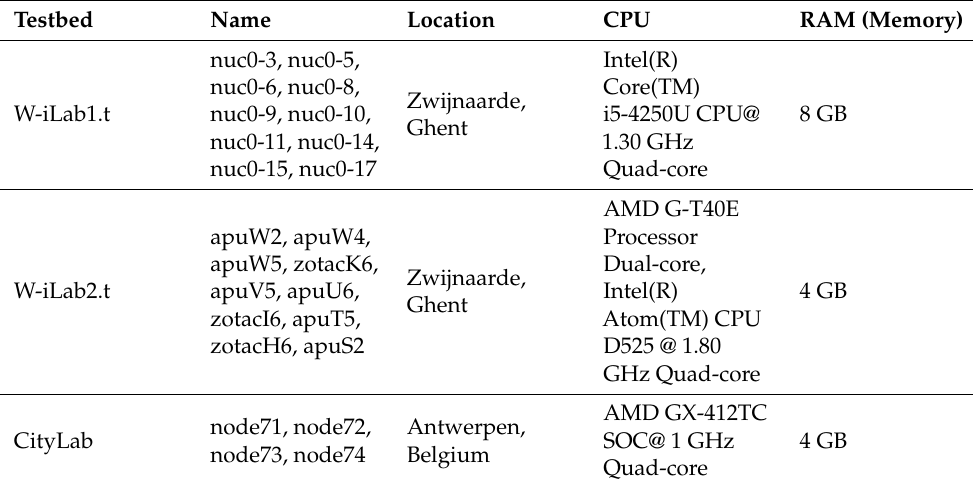
Table 3. Hardware resources used in the single-testbed